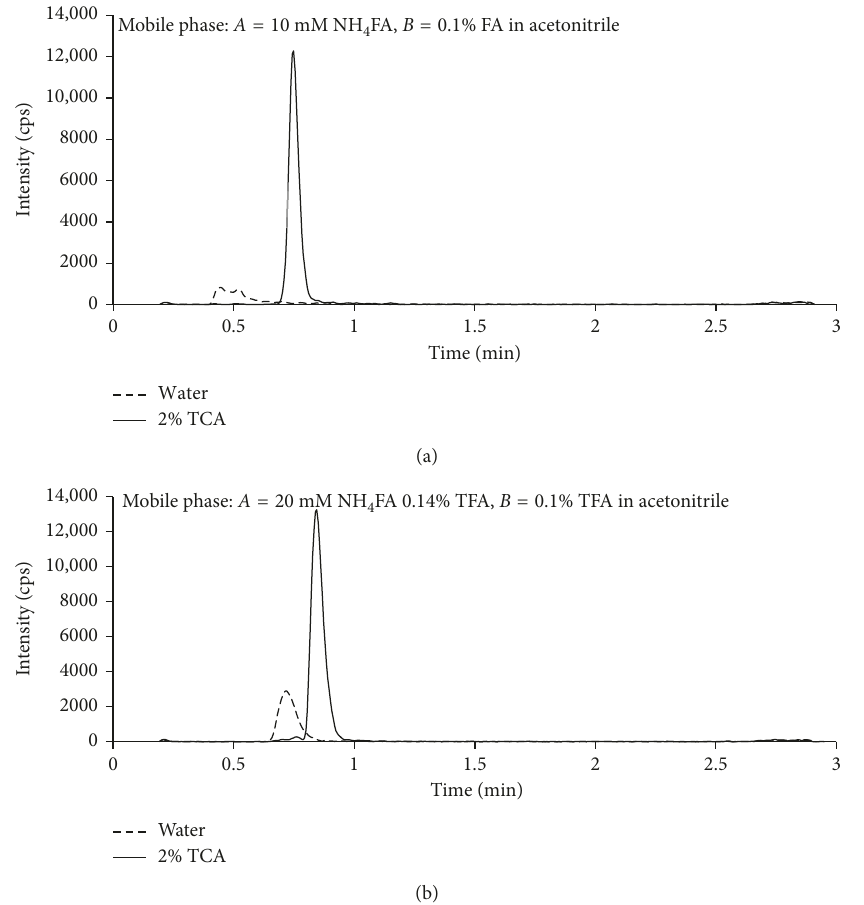
Figure 3: Impact of mobile phase solvents and sample solvents on peak shape, retention time, and signal intensity of TBM. Sample solvents: water (dash line) and 2% TCA (solid line). Mobile phase solvents:10mM NH 4 FA (pH 4.0)-0.1% FA in MeCN (a) and 20mM NH 4 FA 0.14% TFA-0.1% TFA in MeCN